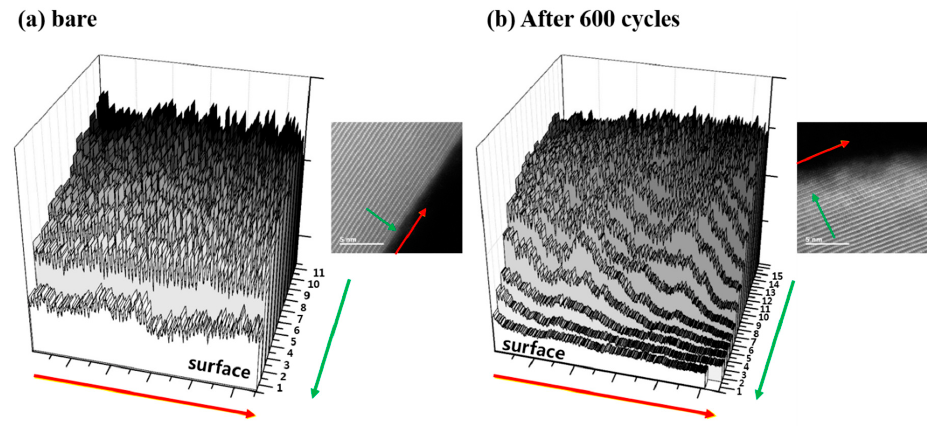
Figure 7. Brightness profile of the NCM811 STEM images: ( a ) bare and ( b ) after 600 cycles at 45 °C.